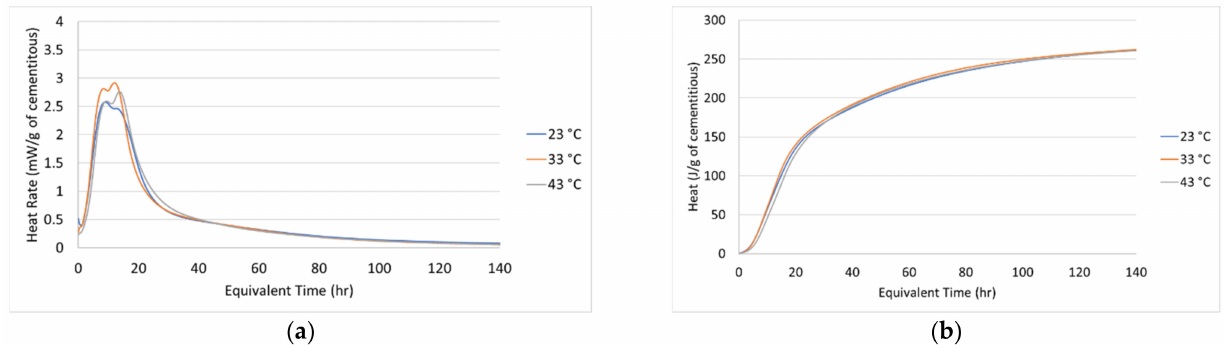
Figure 2. Isothermal at three different temperatures in equivalent age: ( a ) Heat rate and ( b ) Heat.